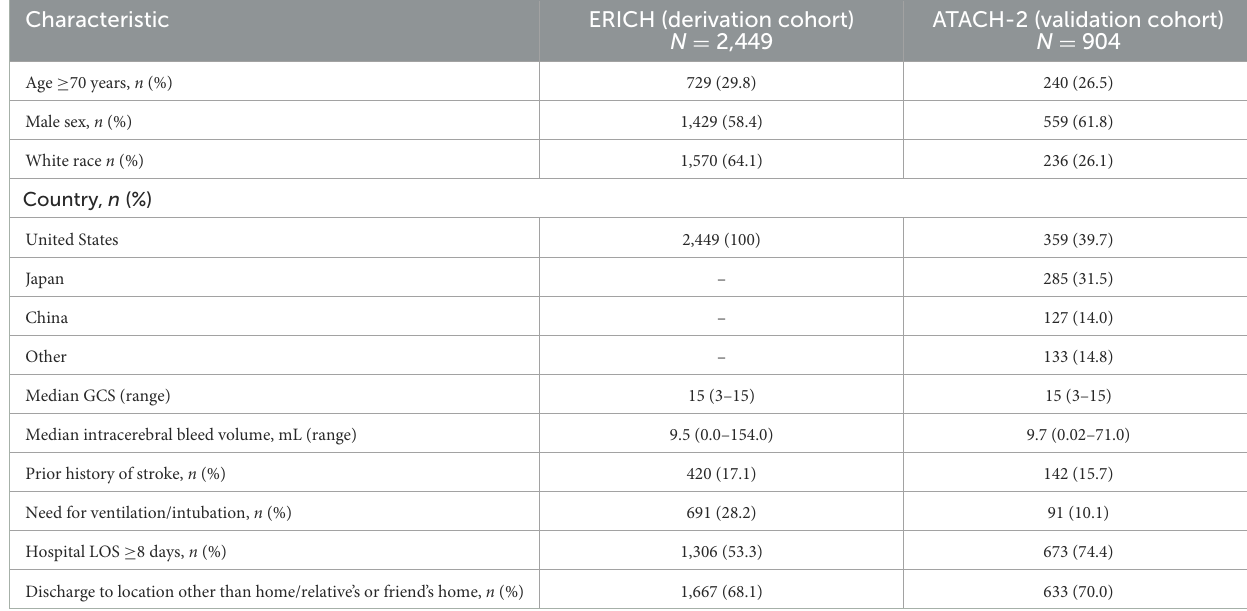
TABLE 2 Demographics and clinical characteristics of the ERICH and ATACH-2 study populations included in the analysis.